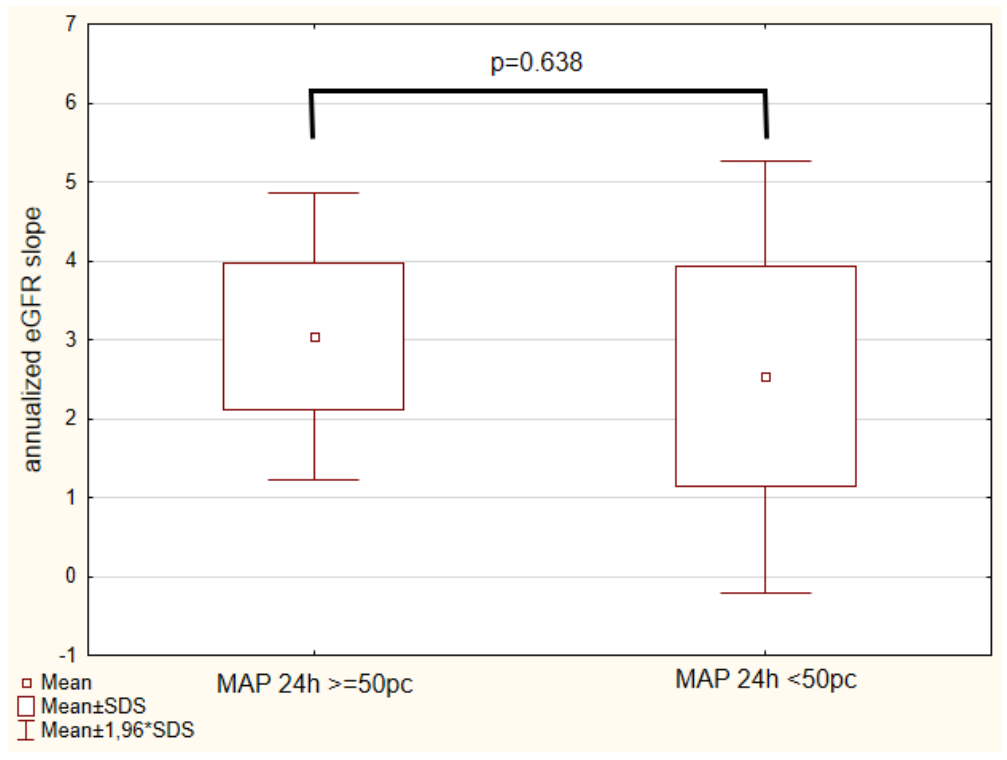
Figure 4. Annualized eGFR slope (mL/min/1.73 m 2 /year) in groups of children with MAP 24 h ≥ 50th percentile and MAP 24 h < 50th percentile. eGFR—estimated glomerular filtration rate, MAP—mean arterial